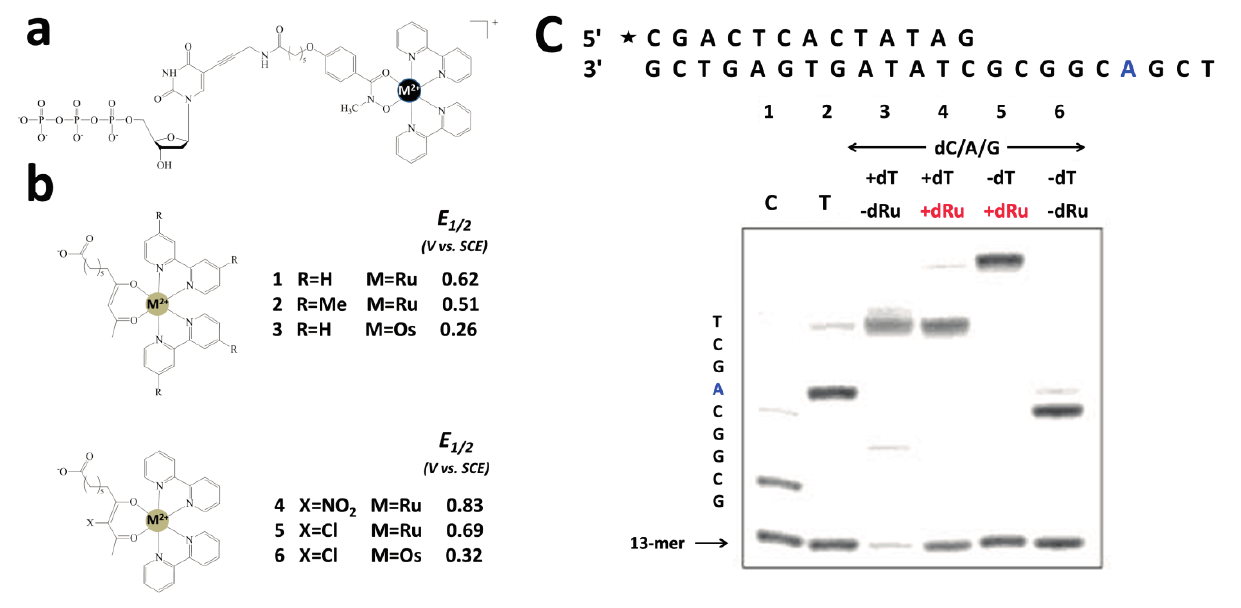
Figure 4. Incorporation of redox active metal complexes into nucleotides for PCR. ( a ) structure of redox-active dTTP analogue; ( b ) structures of metal complexes to be incorporated into nucleotides; ( c ) PCR reaction with electrochemical active nucleotides. Adapted with permission from ref. [58], copyright (2002) American Chemical